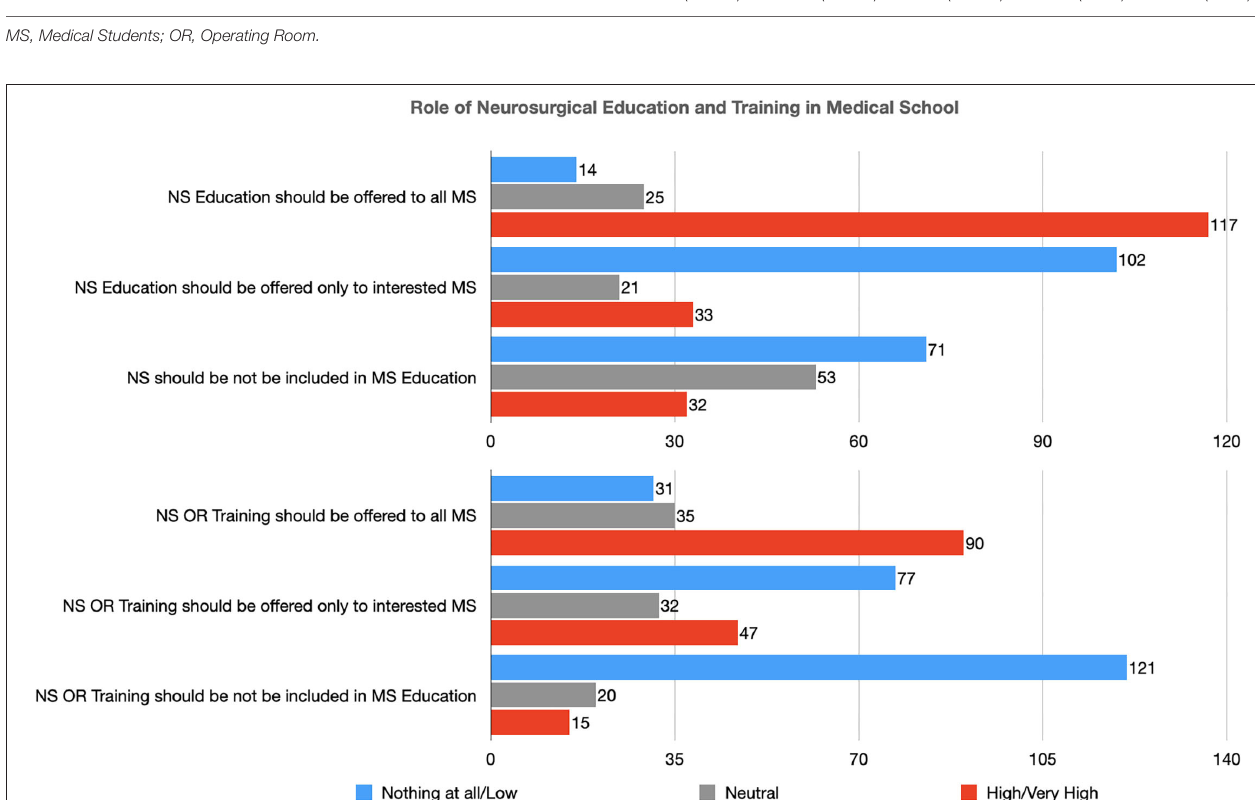
Usefulness of Neurosurgery in